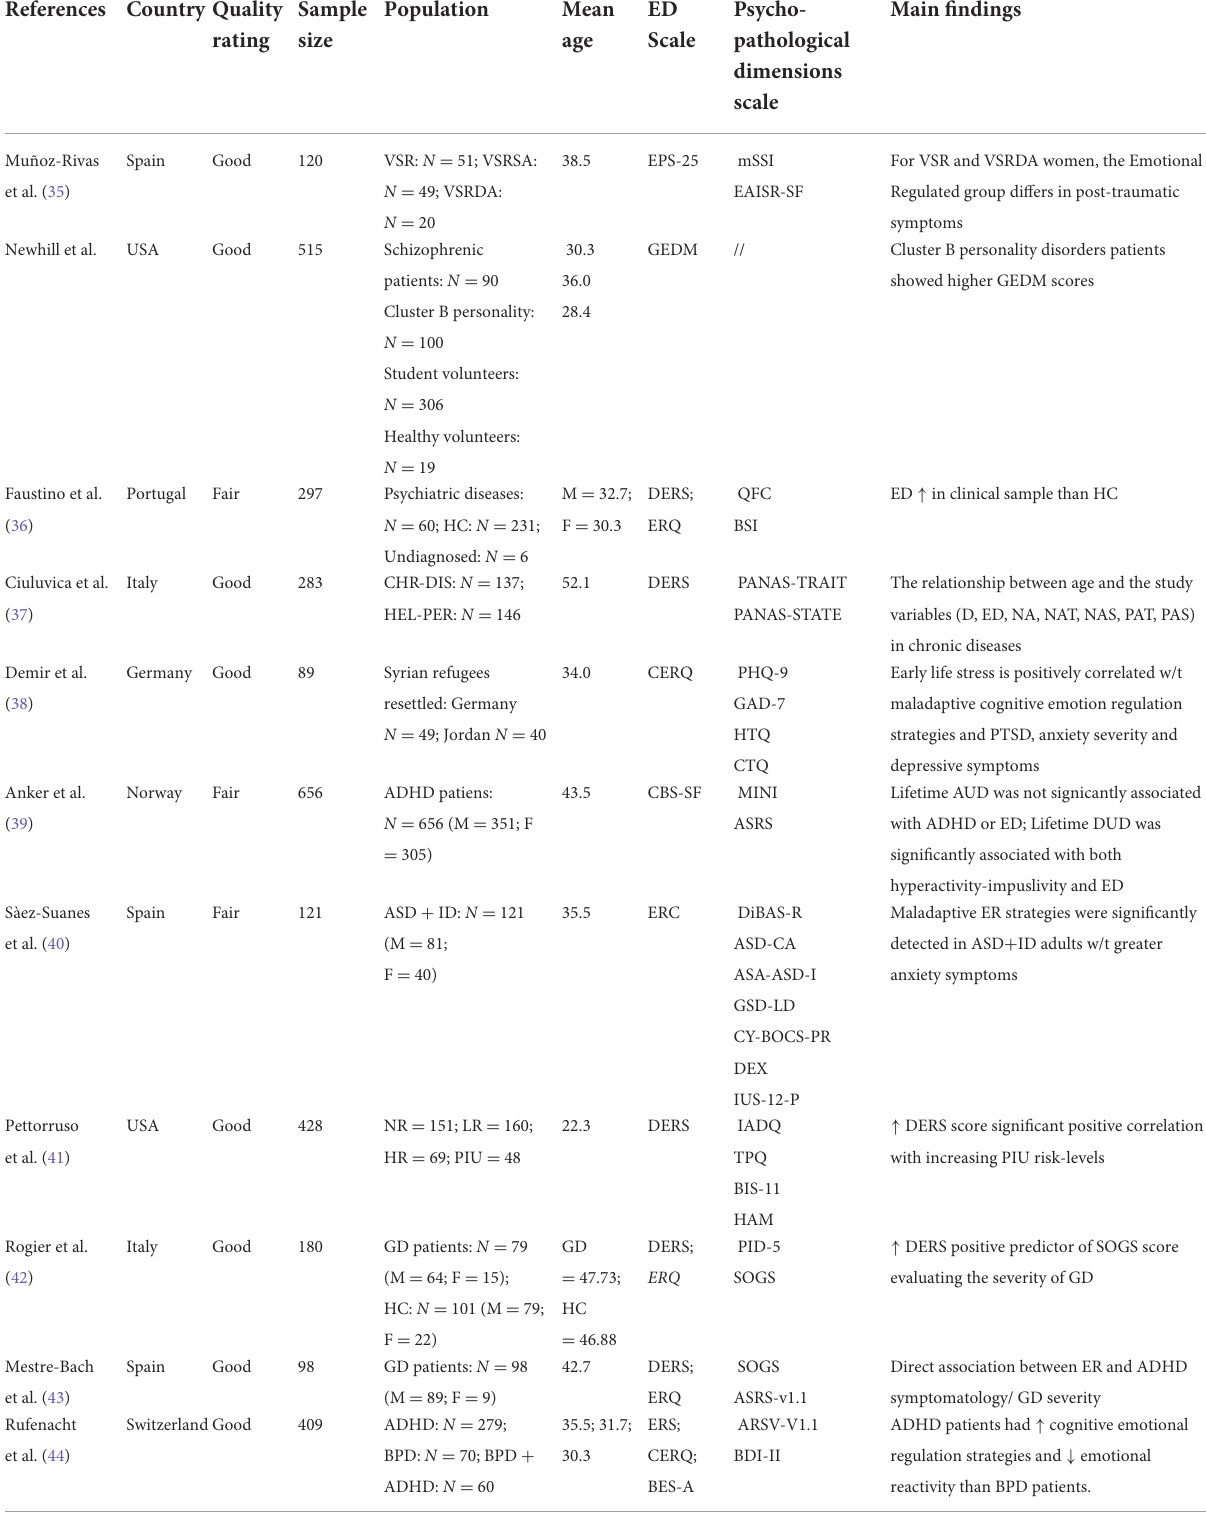
TABLE 1 Characteristics of the studies included in the systematic